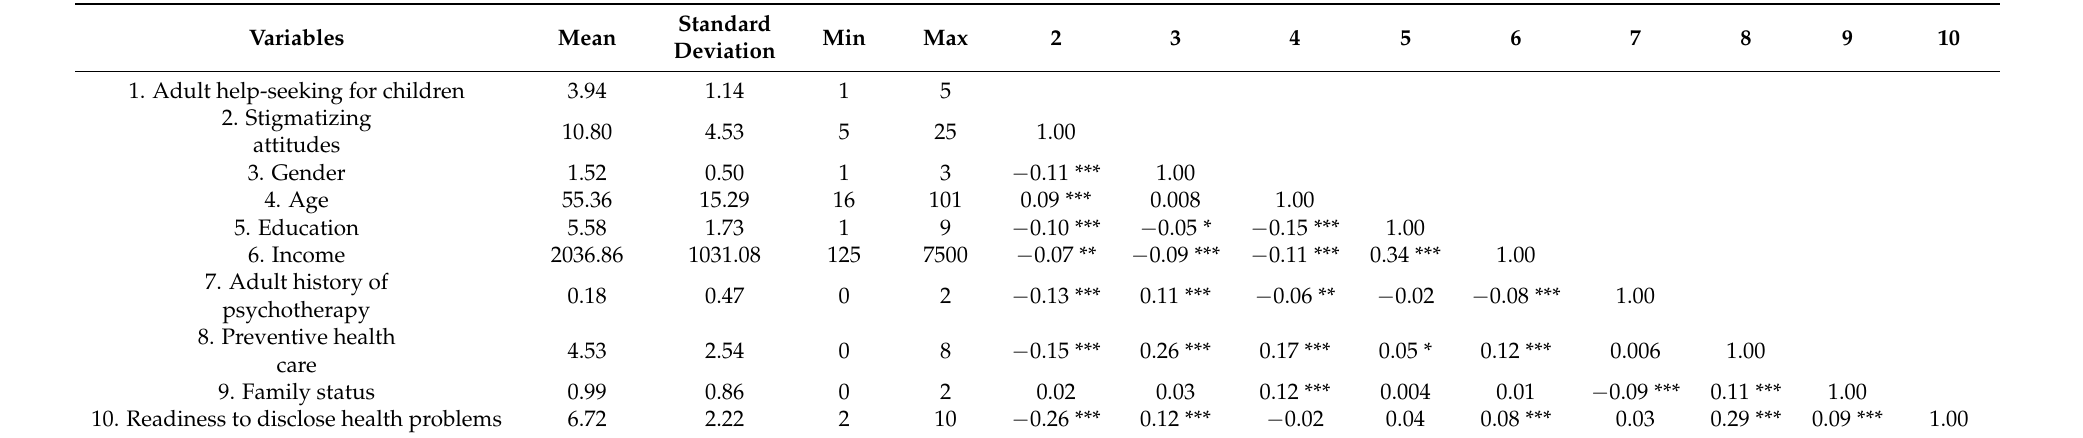
Table 2. Descriptive statistics and correlations (N = 1906). Notes: * p < 0.05; ** p < 0.01; *** p <